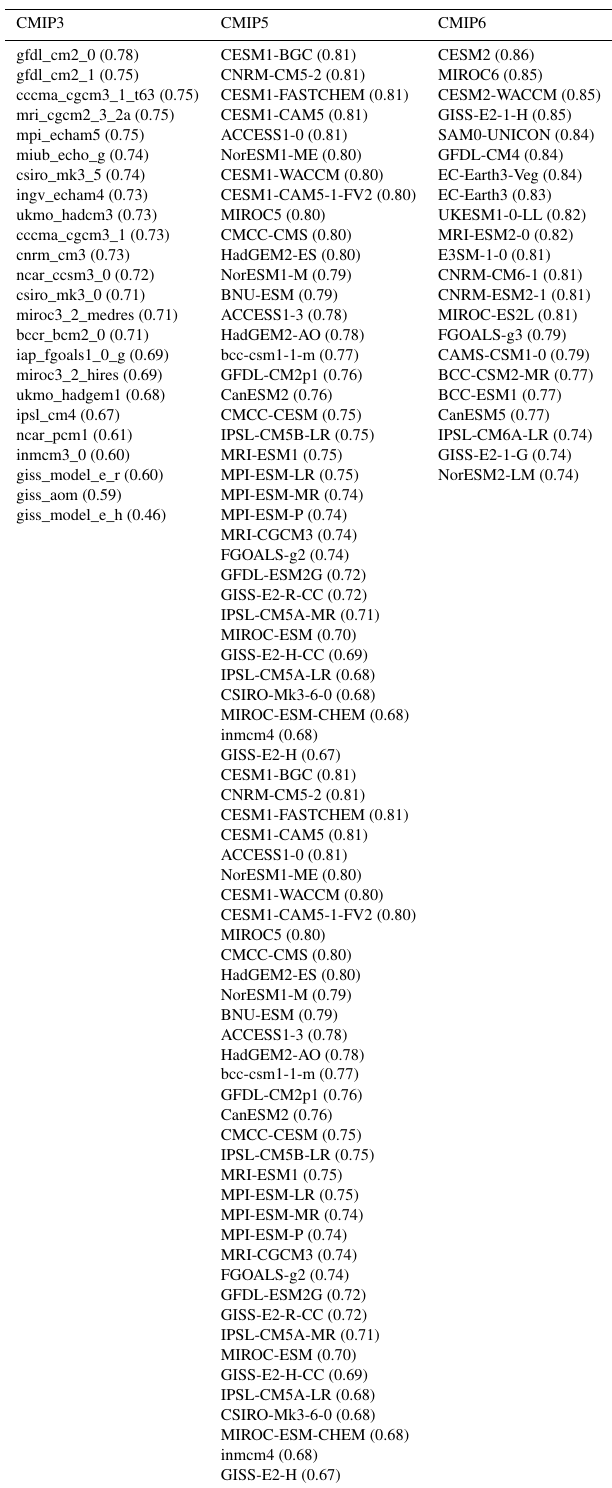
Table 1. Sorted summary of CMIP models considered in this work, sorted by overall